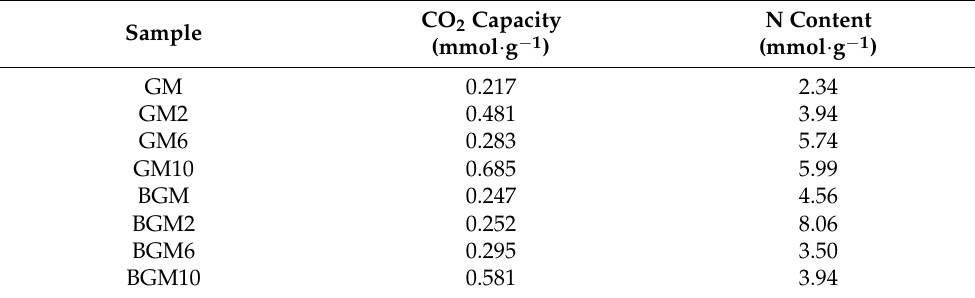
Table 3. CO 2 capture capacities at 75 °C and N contents of the composites .